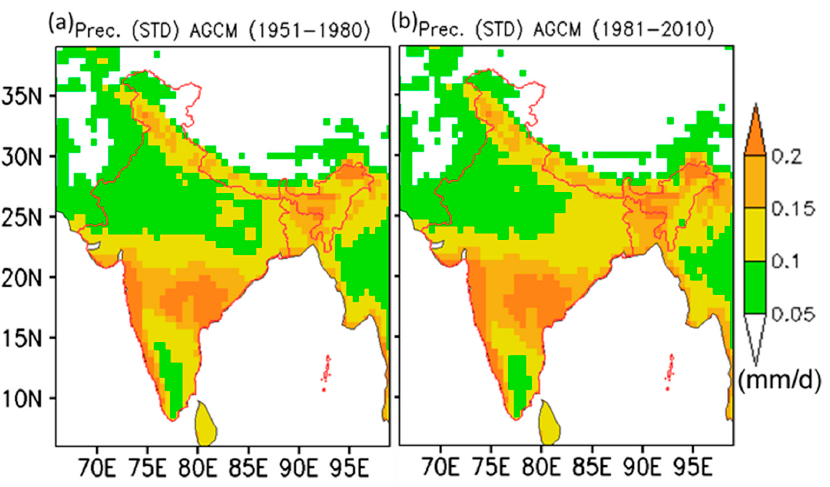
Figure 7. Standard deviation (STD) of the precipitation climatologies derived from all ensemble members in two climate periods ( a ) 1951–1980 and ( b ) 1981–2010. The comparison between the precipitation climatology during 1951–1980 and 1981– 2010 indicates that the pattern of precipitation distribution looks similar over most of the regions in both model and observation, but their magnitudes show some differences. The